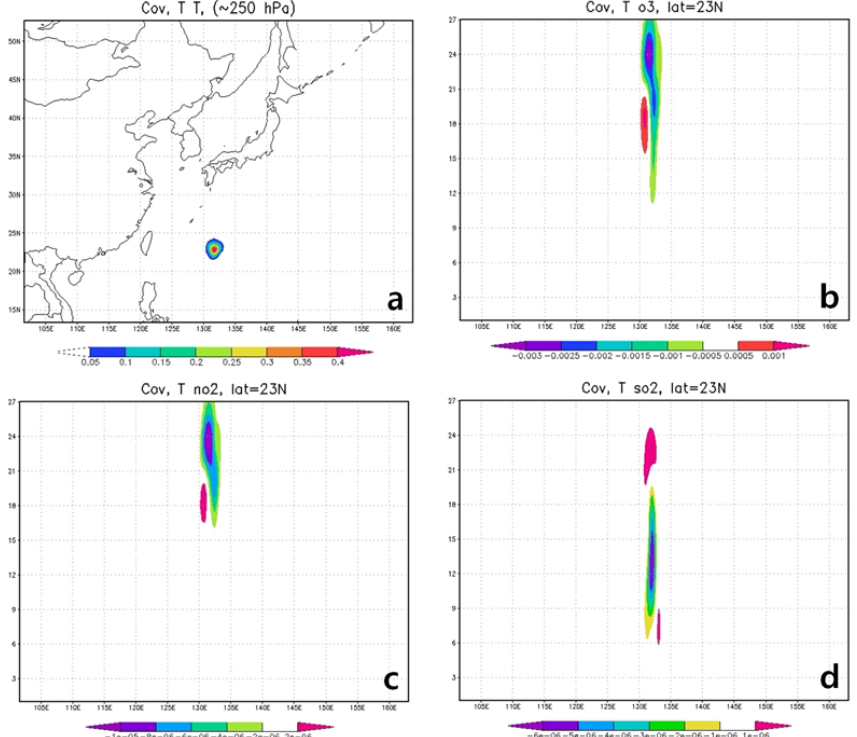
Figure 1. The analysis increments (x a − x f ) in response to a single T observation at 250hPa (near σ level 24): (a) horizontal response of T at 250hPa, and vertical responses of (b) O 3 , (c) NO 2 and (d) SO 2 . In (b) – (d) , the vertical axis represents the vertical σ levels. Units are ppmv for chemical variables and K for